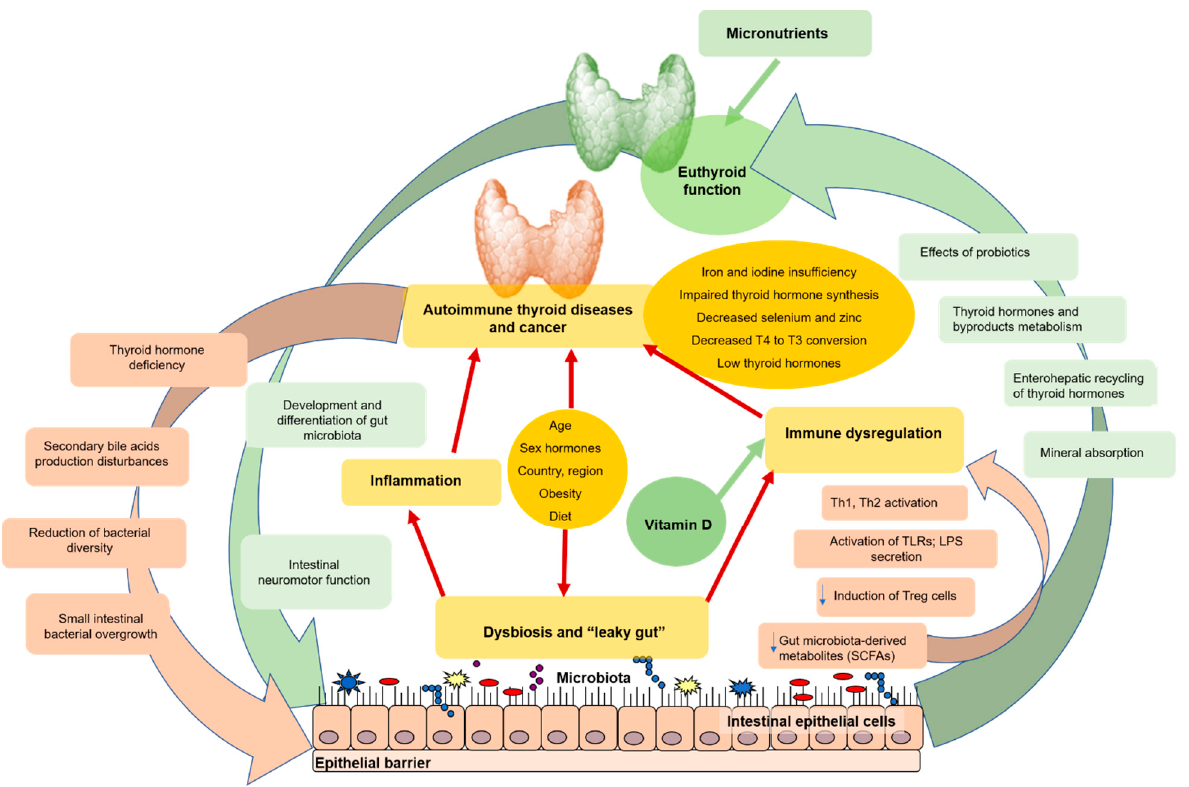
Figure 1. Gut–thyroid interaction in health and disease (autoimmune thyroid pathology and cancer). Thyroid diseases are frequently associated with dysbiosis. On the one hand, dysbiosis changes the immune response by encouraging inflammation and decreasing immunological tolerance, dis- rupting the intestinal membrane and increased intestinal permeability (a.k.a., “leaky gut”), resulting in increased antigen exposure and local inflammation. On the other hand, dysbiosis can directly affect thyroid hormone levels due to bacterial deiodinase activity and TSH inhibition [74]. The gut microbiota also regulates the absorption of thyroid-related nutrients such as iodine, selenium, zinc, and iron. All of them are required for thyroid function, and there is a definite correlation between thyroid dysfunction and changes in these minerals’ levels. Probiotics have been demonstrated to be effective in thyroid problems and can have a good effect. The healthy or diseased thyroid gland can also influence microbiota via many mechanisms, including melatonin. Legend: green arrows (wide and thin) denote a predominantly positive impact, while pink arrows (wide and narrow) indicate a primarily negative effect. 4. Endocrine and Immune Regulators Involved in Adaptation: Vitamin D and Melato- nin 4.1. Essential Effects of Vitamin D and Melatonin on Body Physiology and Cell Function Both vitamin D and melatonin play an essential role in body physiology by control- ling a variety of endocrine and immune responses. Their endogenous rhythmic produc- tion is related to the environmental cycling of light and darkness and is essentially im- portant for ubiquitous cell physiology. Since proper circadian activity of immune and en- docrine axes is a remarkable sign of overall health, vitamin D and melatonin are both promising candidates to be involved in the nutritional management of TH [74]. Data from clinical studies reveal increased prevalence of autoimmune multiple scle- rosis (MS) in countries at high latitudes, where the natural lighting regimen favors vitamin D deficiency and high melatonin levels. Findings from a randomized, double-blind study on interferon beta (IFN- β )-treated patients with MS showed that melatonin secretion is negatively correlated with alterations in serum 25-hydroxyvitamin D 3 (25-OH-D 3 ), which may suggest potential interactions between both hormones with beneficial neuro-im- munomodulating effects under deteriorated immune responses [74].